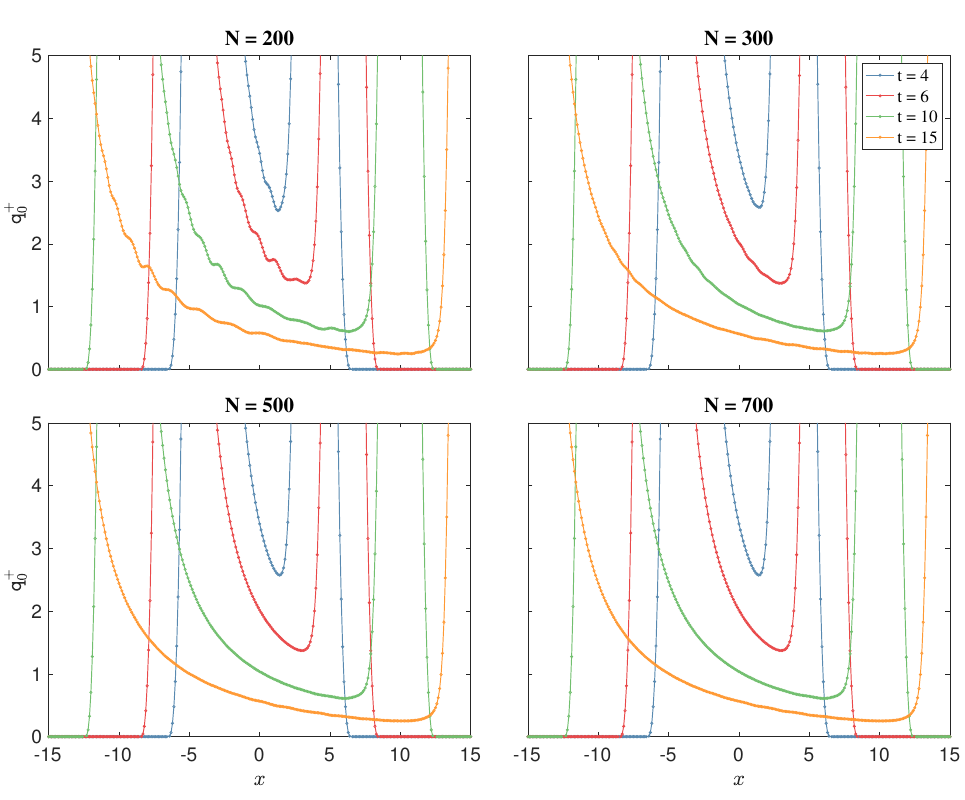
Figure 9: Close-ups of the spatial particle density of particle ( ` ) for different num- bers of points in the fixed rapidity interval θ P r´ 17,17 s and for various times t “ 4,6,10,15. The N “ 200 panel shows regular oscillations. The oscillations per- sist for N “ 300, disappear around N “ 500 and are consistently absent for higher numbers of points, such as N “ 700. Variations of space and time discretisation pa- rameters have not produced any significant changes in the same functions, indicating that a fine enough discretization of the rapidity variable is particularly essential for accuracy due to the integration in the θ variable that is required to compute q `